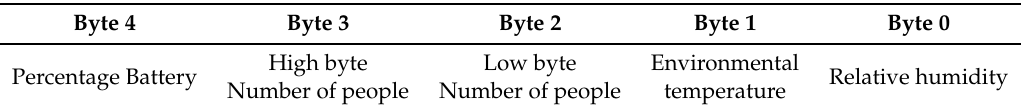
Table 4. Bytes sent by the people counter sensor frame payload in the application layer through the LoRa